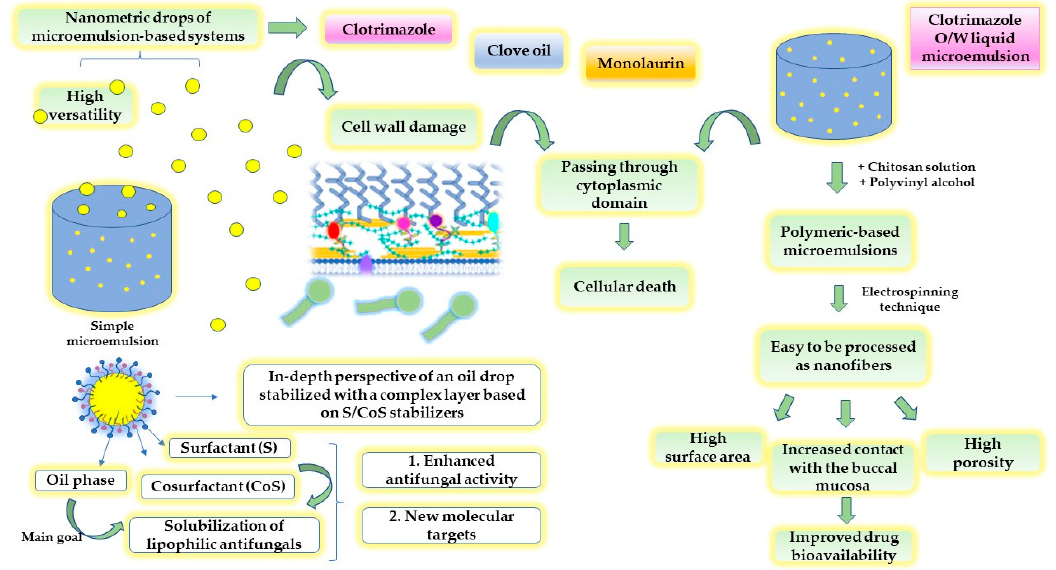
Figure 3. Microemulsion mechanism at the contact with the fungi cell wall and implications in drug processing and delivery.